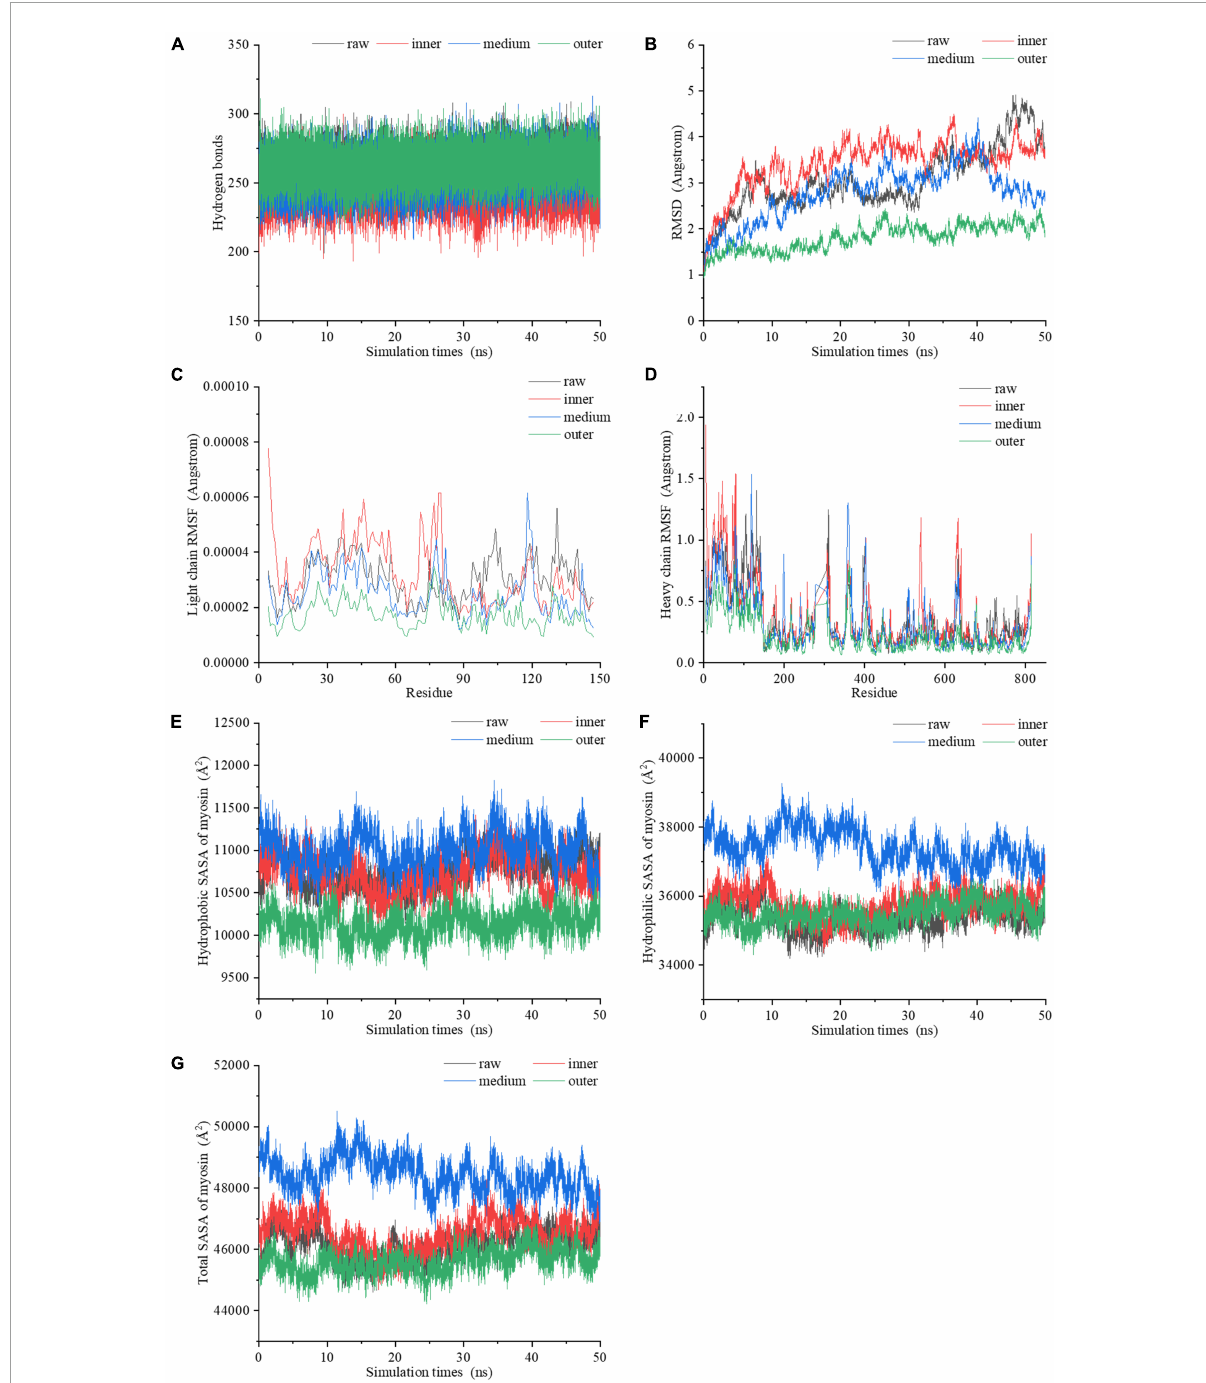
FIGURE5 The dynamic changes of (A) the number of hydrogen bonds, (B) RMSD values, (C) light chain RMSF values, (D) heavy chain RMSF values, (E) hydrophobic SASA, (F) hydrophilic SASA, (G) total SASA of myosin molecules during the 50 ns MDS.